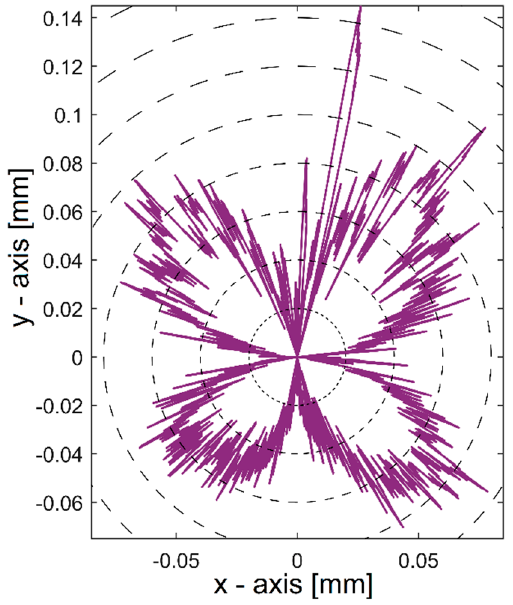
Figure 12. The evolution of TFR 1 .